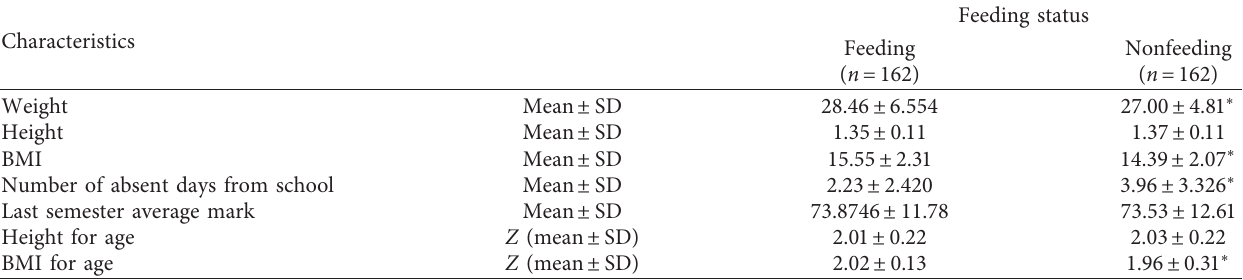
Table 4: Nutritional status and school absenteeism of participants at selected primary schools, Addis Ababa, Ethiopia, August 2018 ( n � 162 for